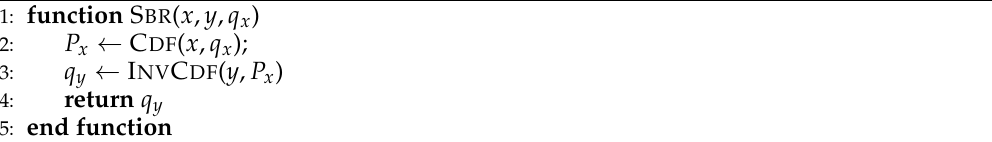
Algorithm 3 Pseudo-code to implement statistical bivariate regression.